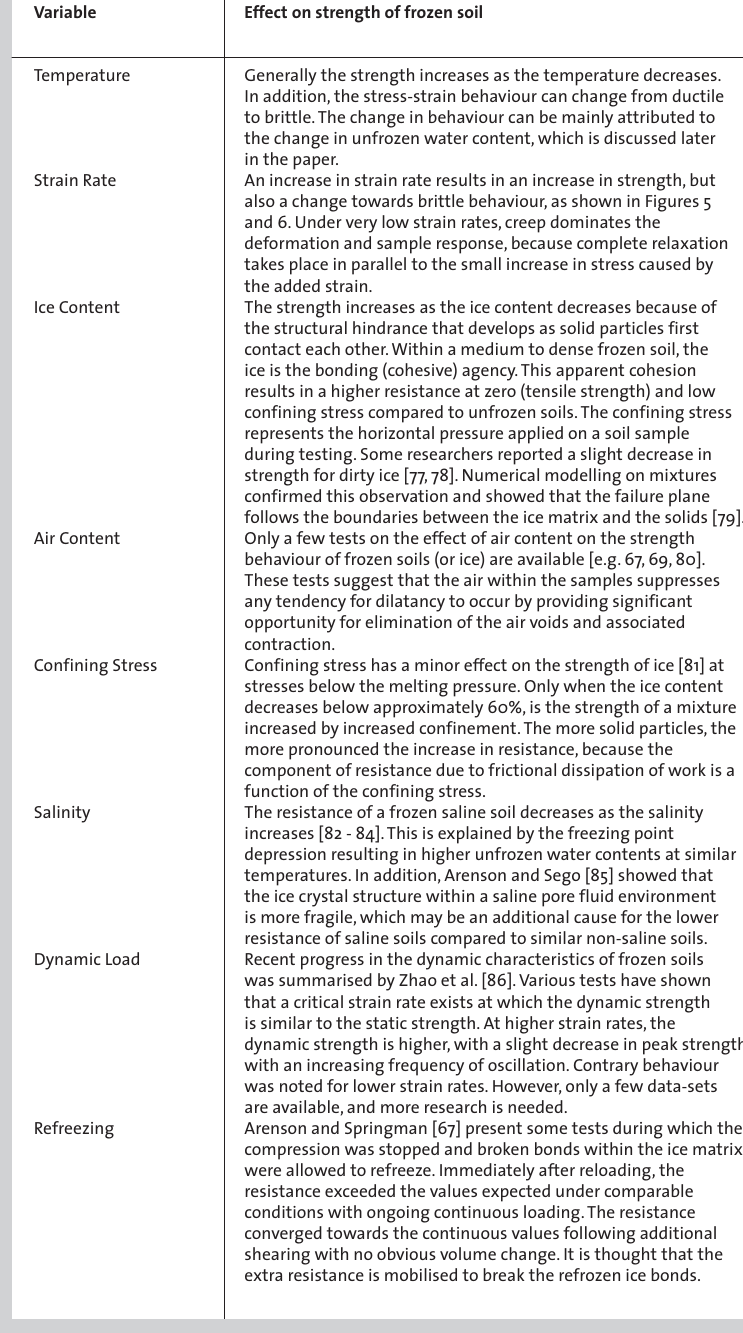
Table 2: Effects of different variables on the strength of frozen